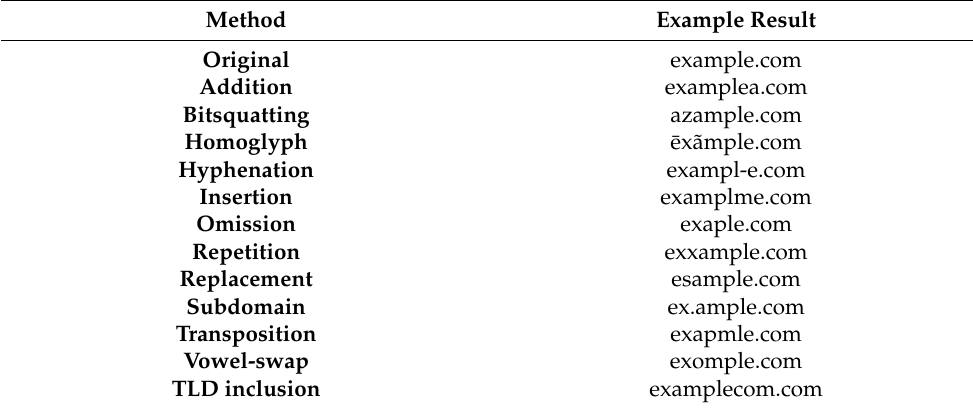
Table 3. Domain variation techniques.